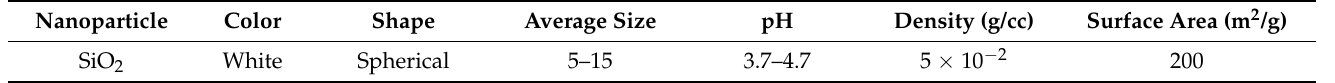
Table 1. The physical and chemical properties of the silica nanoparticles.